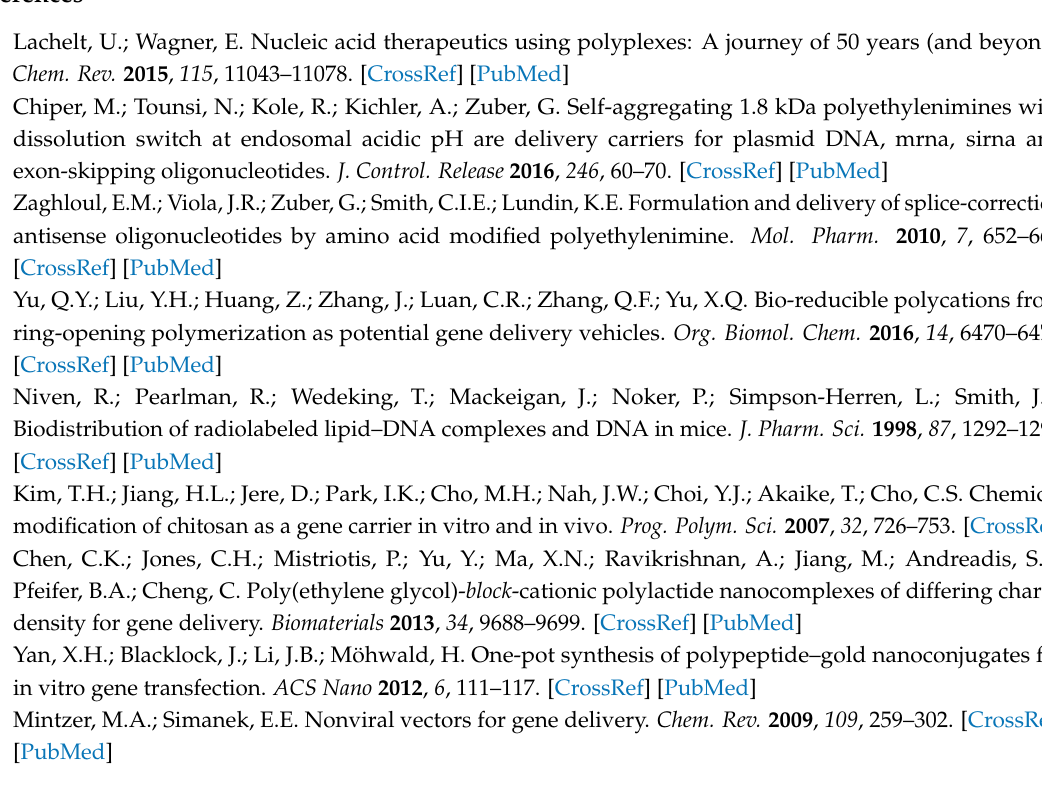
Figure S1: DNA condensation by polycations at various weight ratios evaluated by agarose gel retardation assay. Figure S2: Fluorescence quenching assay of EB/DNA by addition of polycations. Figure S3: Fluorescence spectra of OEI-W10 upon the addition of CT DNA in 2.5 mL Hepes solution (excited at 288 nm) at room temperature. Figure S4: Release of DNA from polyplxes with the addition of heparin at various heparin/DNA weight ratios. w / w = 0, 0.25, 0.5, 1, 2, 4, 8, 16, 32, 64; polymer/DNA: w / w = 1. Figure S5: Fluorescence microscopy image of pEGFP-transfected HEK293 and HeLa cells in the absence serum. Figure S6: ( A ) 1 H NMR spectra (400 MHz, D 2 O) of OEI-W10 ; ( B ) 1 H NMR spectra (400 MHz, D 2 O) of OEI-W15 ; ( C ) 1 H NMR spectra (400 MHz, D 2 O) of OEI-F10 ; ( D ) 1 H NMR spectra (400 MHz, D 2 O) of OEI-F20 ; ( E ) 1 H NMR spectra (400 MHz, D 2 O) of OEI-L10 ; ( F ) 1 H NMR spectra (400 MHz, D 2 O) of OEI-L20 . The characteristic multiplet of δ 7.58–7.16 represents the 5H on indole ring of tryptophan (W), while the broad multiplet represents the C-H of PEI (4H for each ethylenimine unit) and 2H on the -CHCH 2 -on W. The SD can be calculated from the ratio between these peak areas. e.g., in this case, for OEI-W10 , SD = n(W)/n(ethylenimine units on OEI) = (5/5)/[(41.87 − 2)/4] ≈ 0.10, i.e.,